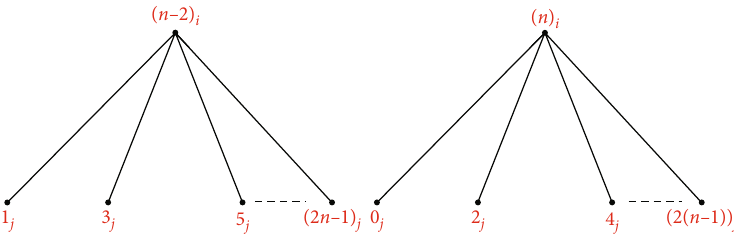
i , j : ∪ K 1,2 2,2 n Þ